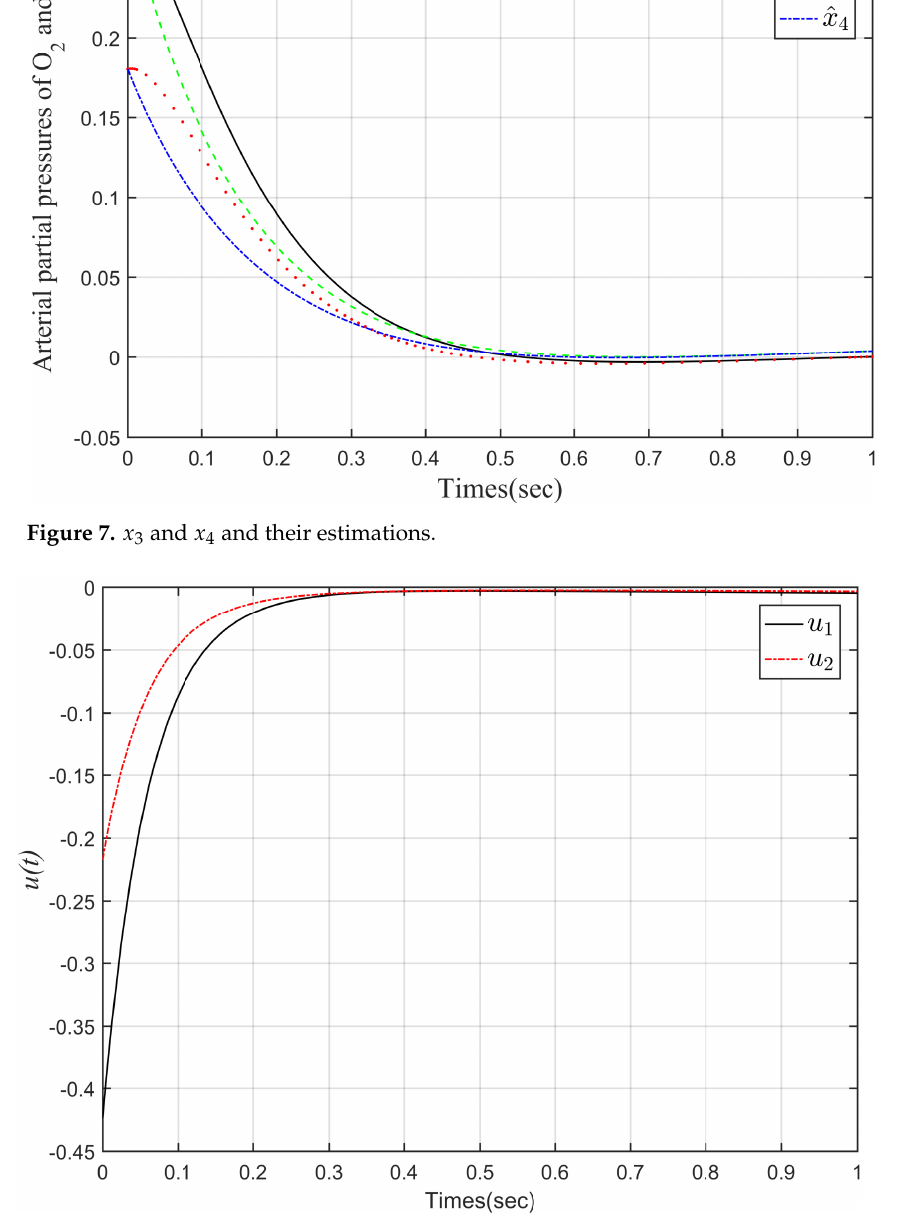
Figure 8. Commanded